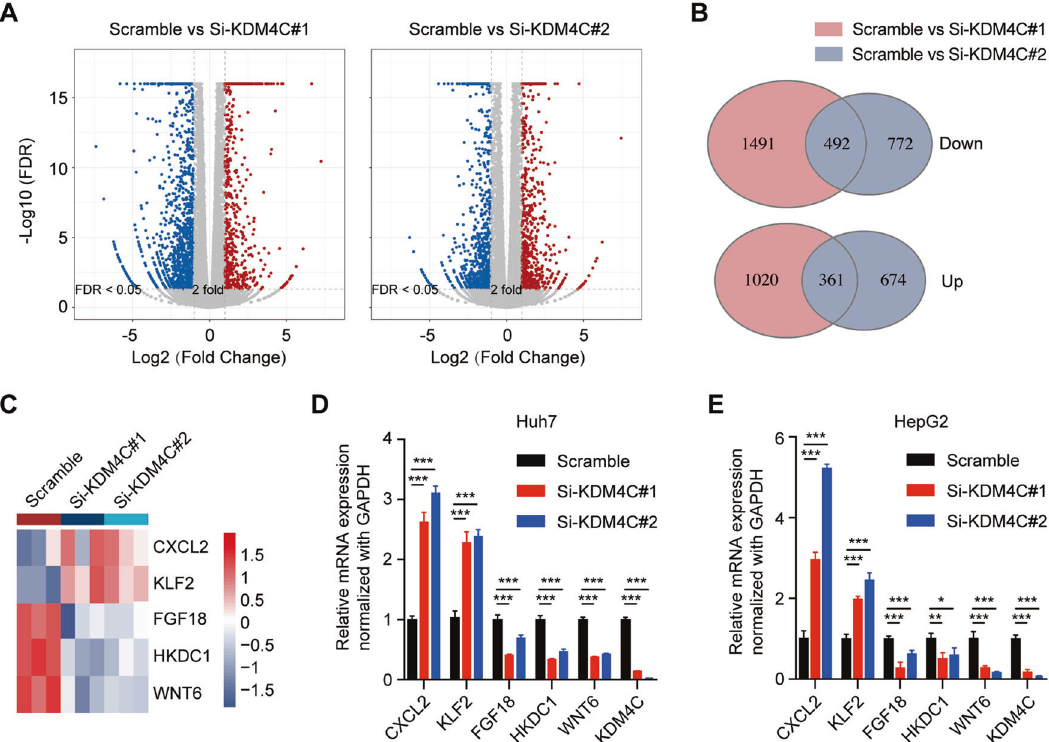
Fig. 6 KDM4C silencing upregulates CXCL2 mRNA expression in HCC cells. A Volcano maps depicting the differentially expressed genes in KDM4C-depleted Huh7 cells compared with Scramble-transfected cells. B Venn diagrams showing co-downregulated and co-upregulated genes. C Heatmap showing screened genes related to HCC. D , E Relative mRNA expression levels of genes in Huh7 and HepG2 cells transfected with the indicated siRNAs were measured using quantitative real-time PCR ( n =